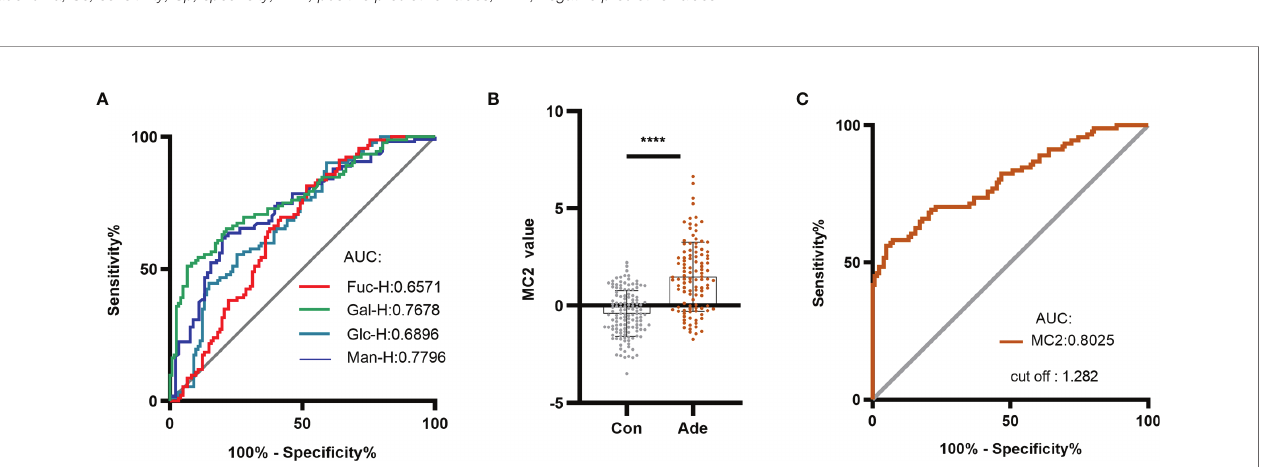
FIGURE 5 | Establishing the MC2 diagnostic model for CRA and evaluating its diagnostic performance. (A) ROC analysis distinguished between healthy individuals and CRA patients using serum monosaccharides. Based on the serum monosaccharides concentrations in healthy individuals and CRA patients, a diagnostic model named MC2 was established by logistic regression analysis. (B) MC2 values were compared between healthy individuals and patients with CRA in the training group. (C) ROC curve analysis of MC2 was performed to differentiate healthy individuals from CRA patients. **** p ≤ 0.0001.